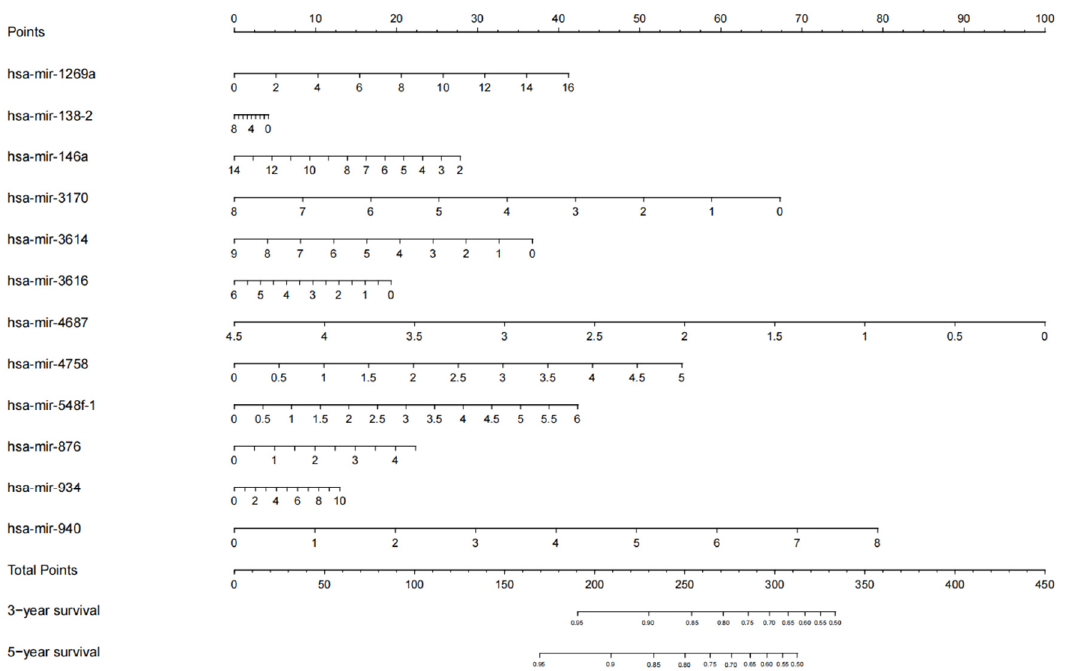
Figure 4. The prognostic nomogram established by 12 miRNAs was used to predict 3- and 5-year OS of patients with EC. Including data derived from 536 EC specimens and 33 non-tumor tissues. The nomograms are interpreted by adding up the points assigned to each variable, as indicated at the top of the point scale. The total point projected on the bottom scale represents the probability of 3- or 5-year OS.